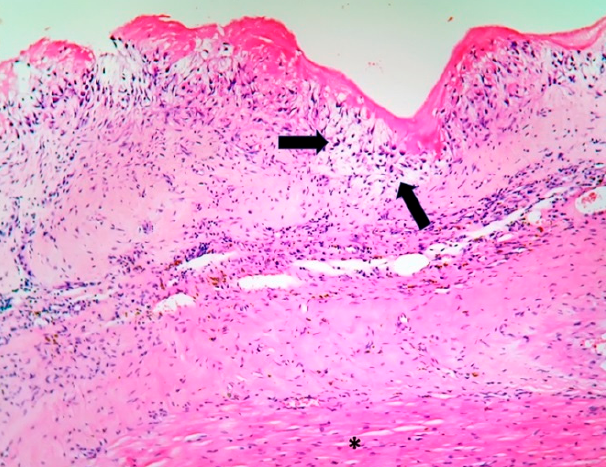
Figure 4. Tricuspid valve endocarditis; a multinucleated cell (arrow) within the mild inflammation at the vegetation base (arrow) (HE stain × 10).